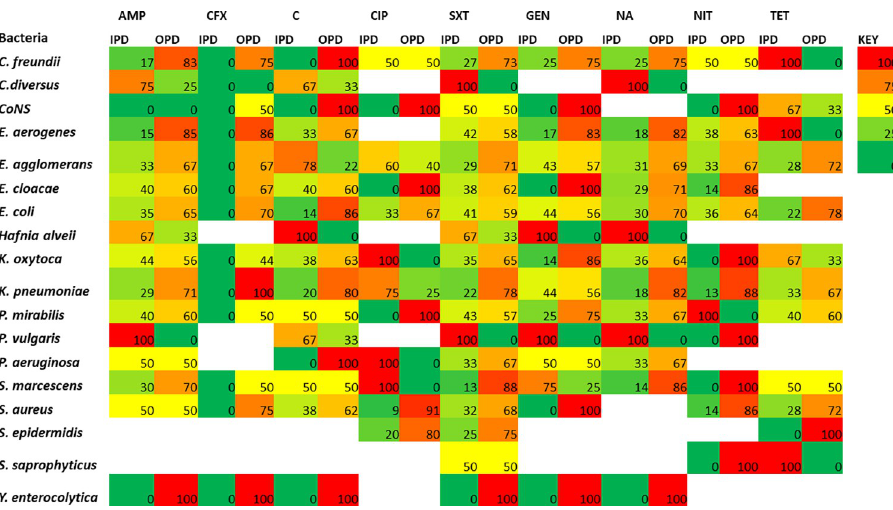
Fig 2. The resistance patterns in percentages of bacteria on wisely used antibiotics. The colour coded graph showed resistance pattern ranging from the least (0%, in green) to most resistant strain (100%, in red). Bacteria that were not tested on some antibiotics are shown with blank spaces. AMP: ampicillin, CFX: cefotaxime, C: chloramphenicol, CIP: ciprofloxacin, SXT: cotrimoxazole, GEN: gentamicin, NA: nalidixic acid, NIT: nitrofurantoin, TET: tetracycline, IPD: in-patient department, OPD: outpatient department, CoNS: Coagulase negative Staphylococci. Graph key shows increased colour intensity from green (0%) to red